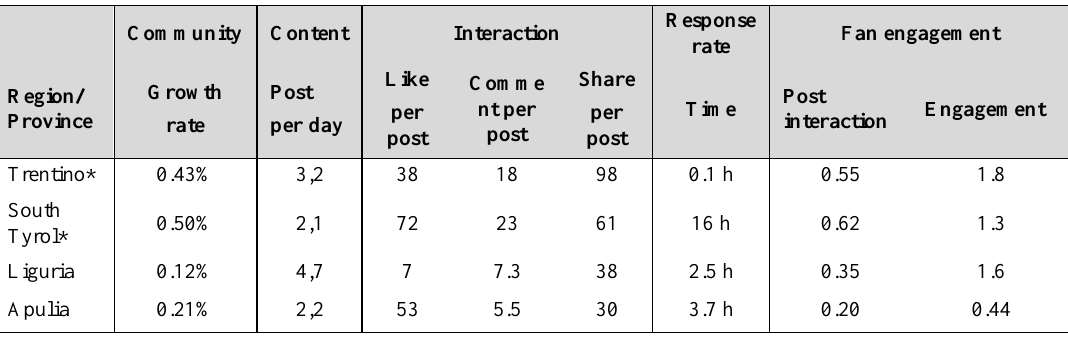
Table 3: DMO Facebook performance. April